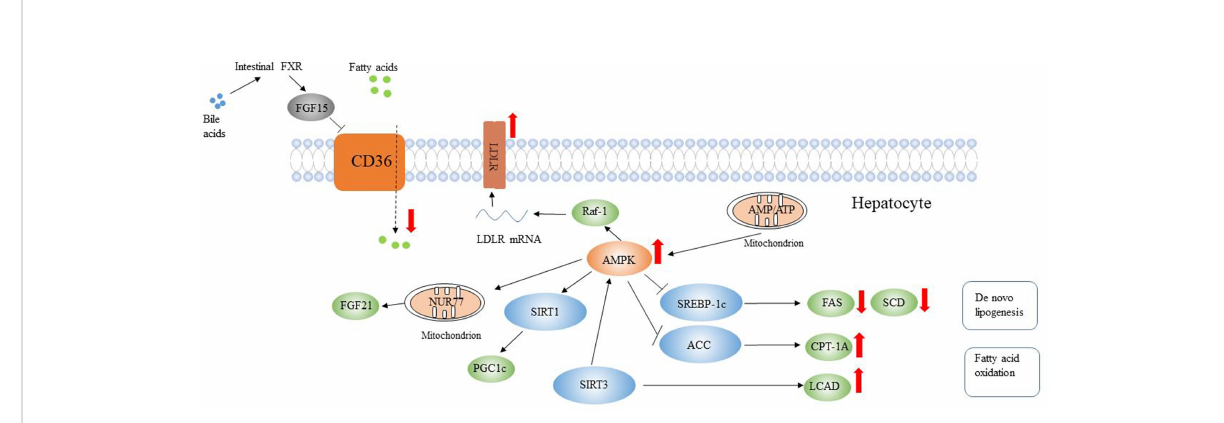
FIGURE 3 The potential mechanisms of berberine in reducing liver lipid accumulation. Berberine inhibits hepatic lipid absorption by the intestinal microbiota-bile acid-FXR pathway. Berberine inhibits de novo lipogenesis but improves fatty acid oxidation via activation of AMPK. Berberine increases LDLR expression and LDLR mRNA stabilization. Up arrows indicate an increase or activation, and down arrows indicate a decrease or suppression. Modi fi ed from Xu et al. (2021) and Zhou et al.